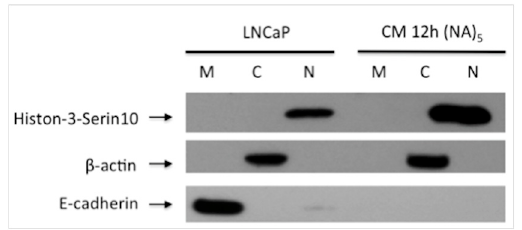
Figure 2. Alteration of Expression E-cadherin and phospho-Histone 3 S10 in the Inflammatory Microenvironment. In the migrated cells, E-cadherin expression was decreased, meanwhile Histone 3-Ser10 was increased then LNCaP cells. M: Membrane, C: Cytoplasmic, N: Nuclear fraction after subcellular protein isolation. CM 12 h (NA) 5 : 5th generation cells obtained after migration assay and changed their properties as a